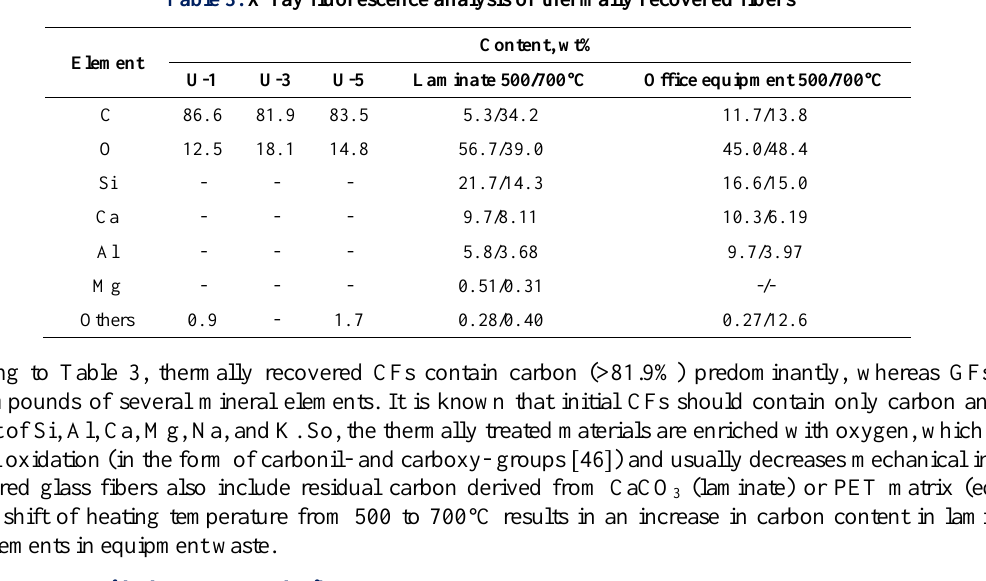
Table 4. Strength of slag-based building blocks reinforced with obtained GFs (* 6 samples; ** 4 samples) Characteristics of samples